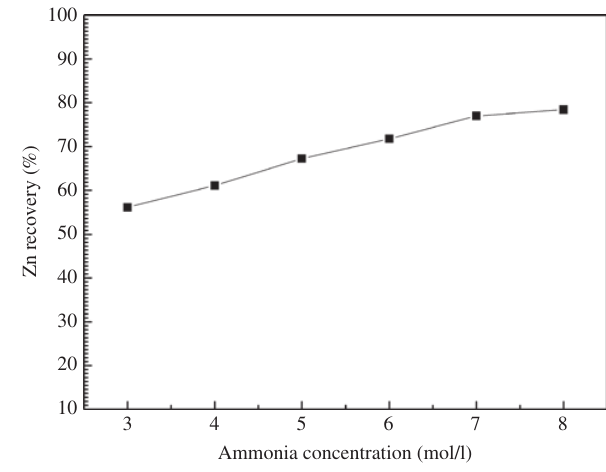
Figure 6: Effects of different ammonia concentrations on the zinc recoveries of the roasted ores.